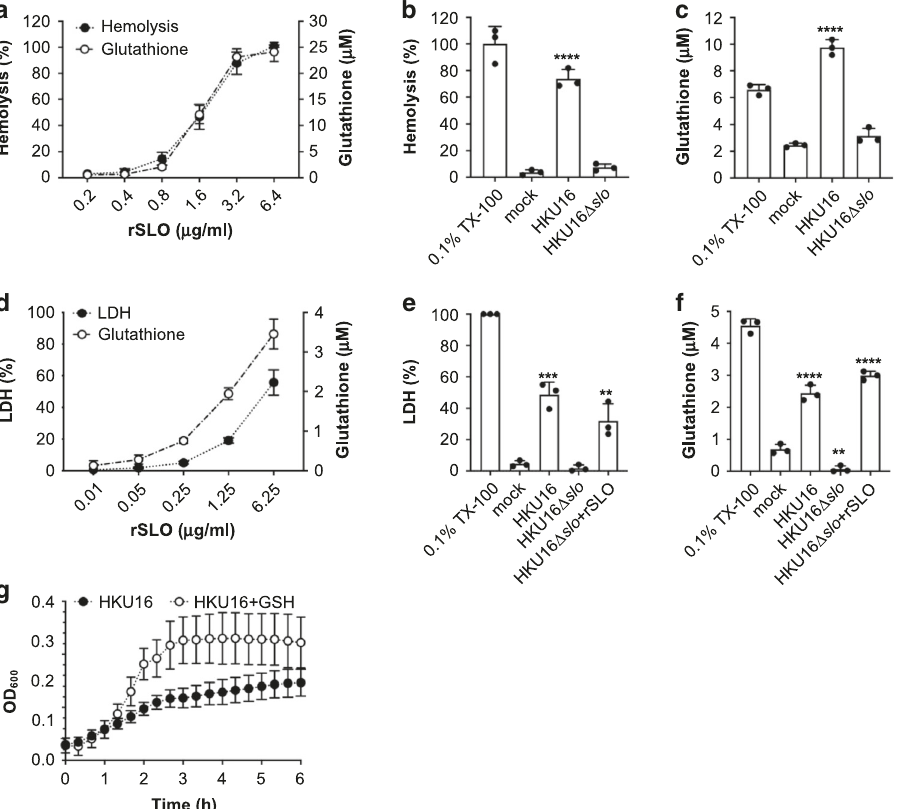
Fig. 2 The cytotoxic activity of SLO causes the release of host cytosolic glutathione. a Dose-dependent hemolytic activity of puri fi ed recombinant SLO (rSLO) in whole human blood is accompanied by an extracellular accumulation of glutathione. Hemolysis is expressed as percentage± SD with respect to the positive control (cells treated with 0.1% Triton X-100 (TX-100)) ( n = 4). b Hemolytic activity of indicated HKU16 strains is expressed as percentage ± SD ( n = 3) with respect to the positive control (cells treated with 0.1% TX-100). Blood treated with HBSS (mock) served as a negative control. Statistical signi fi cance was assessed using one-way ANOVA with Dunnett ’ s multiple comparisons post hoc test against the mock control group (**** p < 0.0001 for HKU16). c Extracellular accumulation of glutathione in blood ( n = 3) infected with indicated HKU16 strains. Blood treated with HBSS (mock) served as a negative control. Statistical signi fi cance was assessed using one-way ANOVA with Dunnett ’ s multiple comparisons post hoc test against the mock control group (**** p < 0.0001 for HKU16). d Release of lactate dehydrogenase (LDH) (closed circles) and glutathione (open circles) by pharyngeal cells treated with varying concentrations of recombinant SLO. The release of LDH and glutathione into the culture medium was assessed after 2 h of treatment. LDH release is expressed as percentage ± SD with respect to the positive control (cells treated with 0.2% TX-100). Cells treated with growth medium (mock) served as a negative control. Data shown are representative of three independent experiments. LDH ( e ) and glutathione ( f ) release by pharyngeal cells challenged with indicated HKU16 strains at a multiplicity of infection of 20:1 (bacterial colony forming units (CFU):cells), assessed at 2 h post infection ( n = 3). Where indicated, rSLO was added to HKU16 Δ slo -infected cells at a concentration of 6.25 µ g/ml. Statistical signi fi cance was assessed using one- way ANOVA with Dunnett ’ s multiple comparisons post hoc test against the mock control group ( e *** p = 0.0002 for HKU16, and ** p = 0.0034 for HKU16 Δ slo + rSLO; f **** p < 0.0001 for HKU16, ** p = 0.0049 for HKU16 Δ slo , and **** p < 0.0001 for HKU16 Δ slo + rSLO). g Growth curves of HKU16 in pharyngeal cell-free culture medium (EMEM + 10% FBS) supplemented with 2 mM of GSH ( n = 3). All data are presented as mean values ± SD. Source data are provided as a Source Data fi